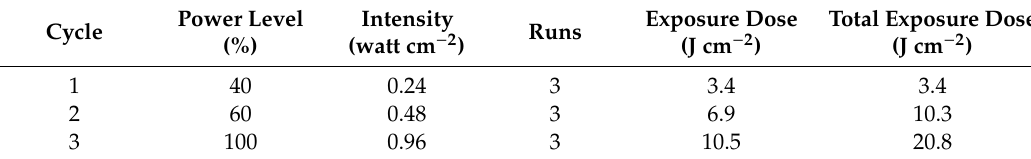
Table 2. Exposure profile applied for specimen production.